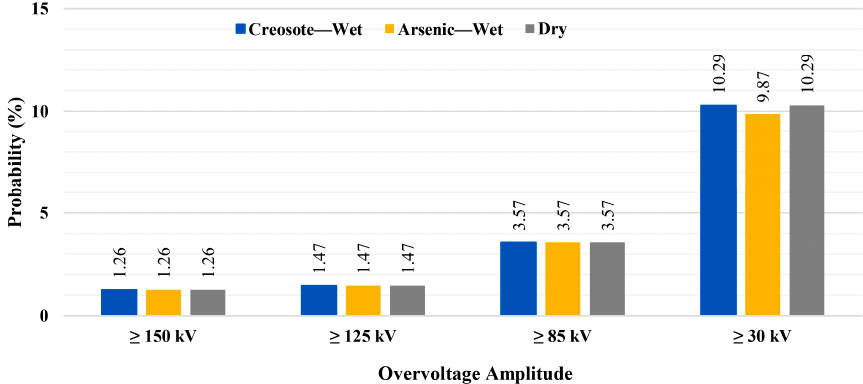
Figure 14. Comparison among the probabilities of transformer overvoltage tension under three network configurations. Case 2, grounding one intermediate pole between two transformer poles.